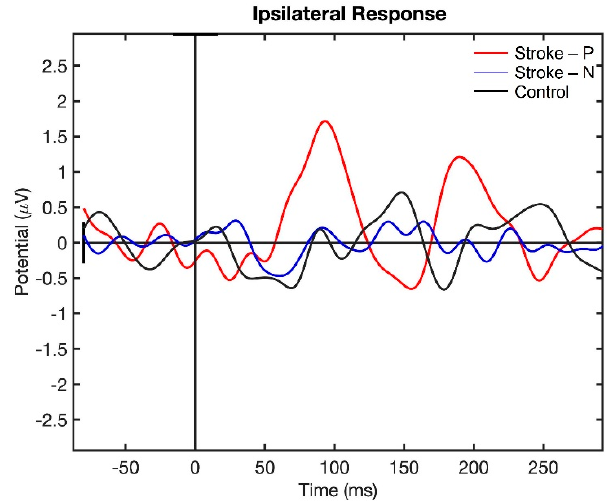
Figure 3. Ipsilateral Somatosensory Evoked Potential (SEP) response to finger stimulation. Stroke-P (red): paretic hand was stimulated. Stroke-N (blue): non-paretic hand was simulated. Control (Black): dominant hand was stimulated.